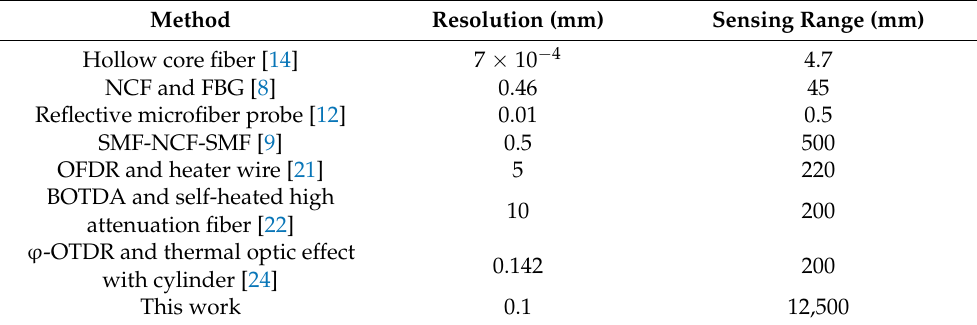
Table 1. Sensing resolution and sensing range of several liquid-level